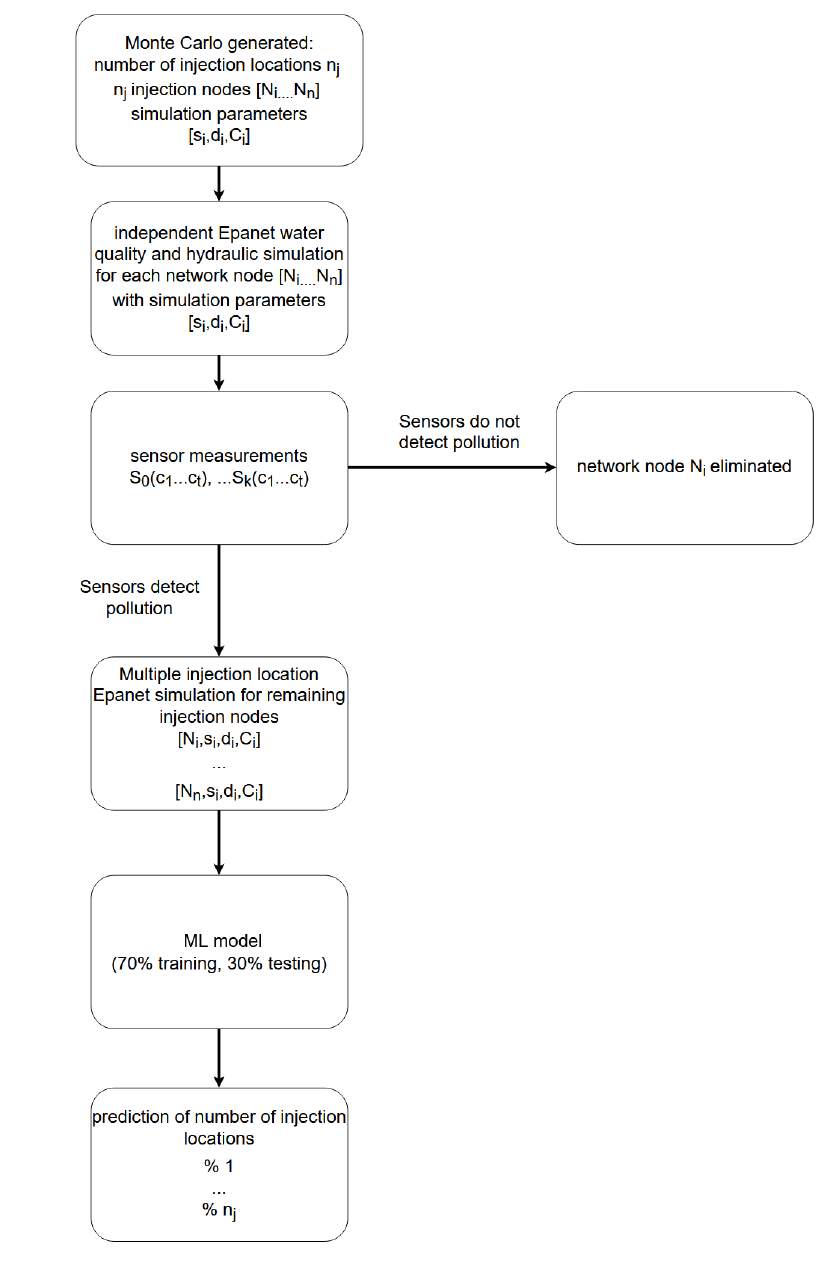
Figure 5. Flowchart of Machine Learning algorithm for prediction of number of contamination